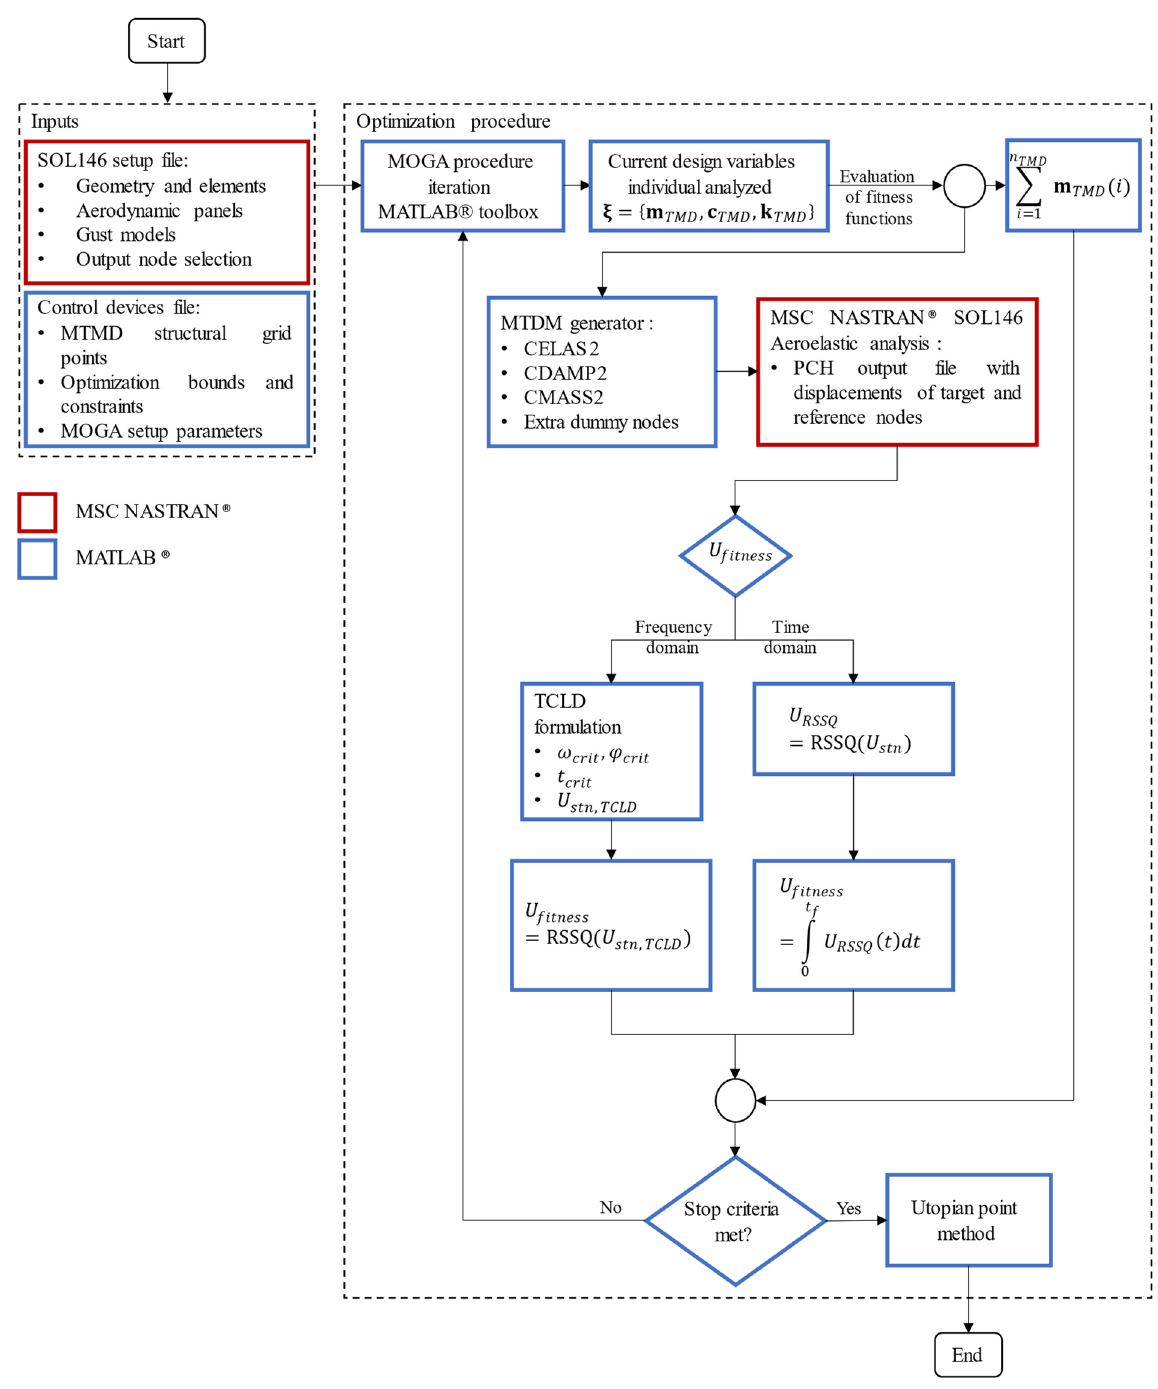
Figure 3. Flowchart of the developed optimization procedure.